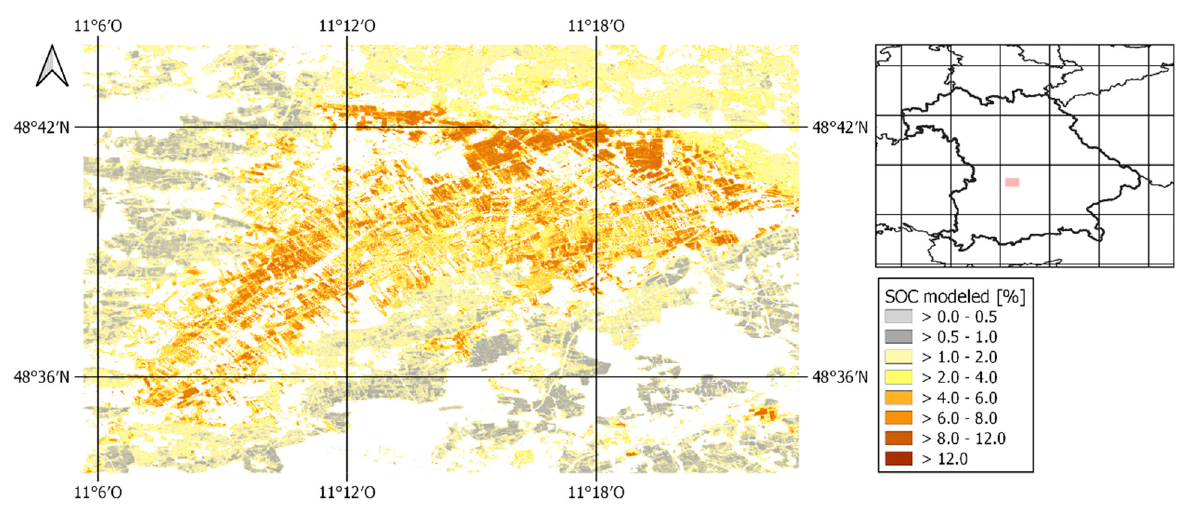
Figure 12. The spatial distribution of SOC contents for a subset of the investigation data. The prediction possibilities of field scale are visible.